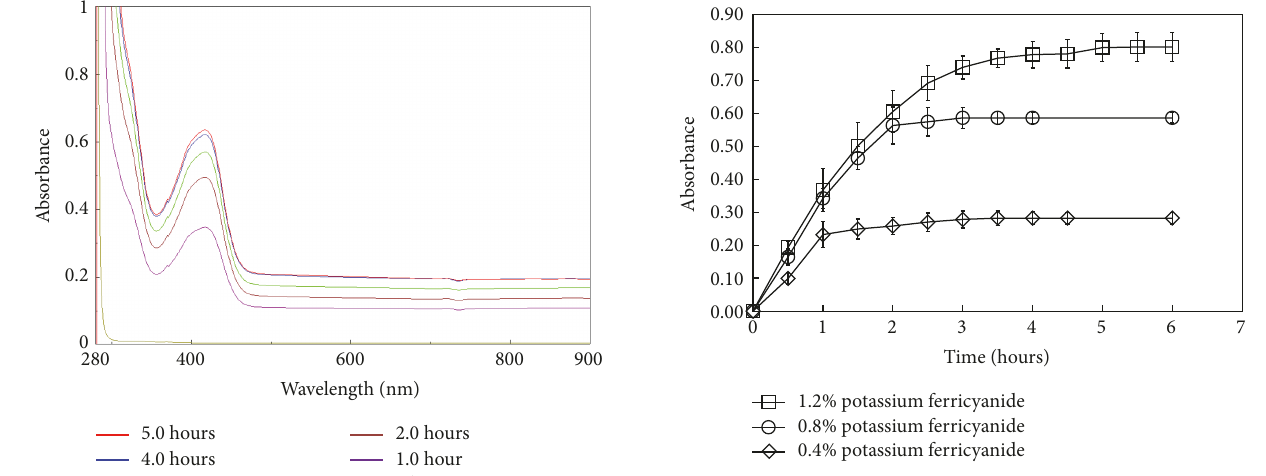
Figure 9: Effects of potassium ferricyanide concentration on trans- dermal delivery with a 5 𝜇 m membrane pore